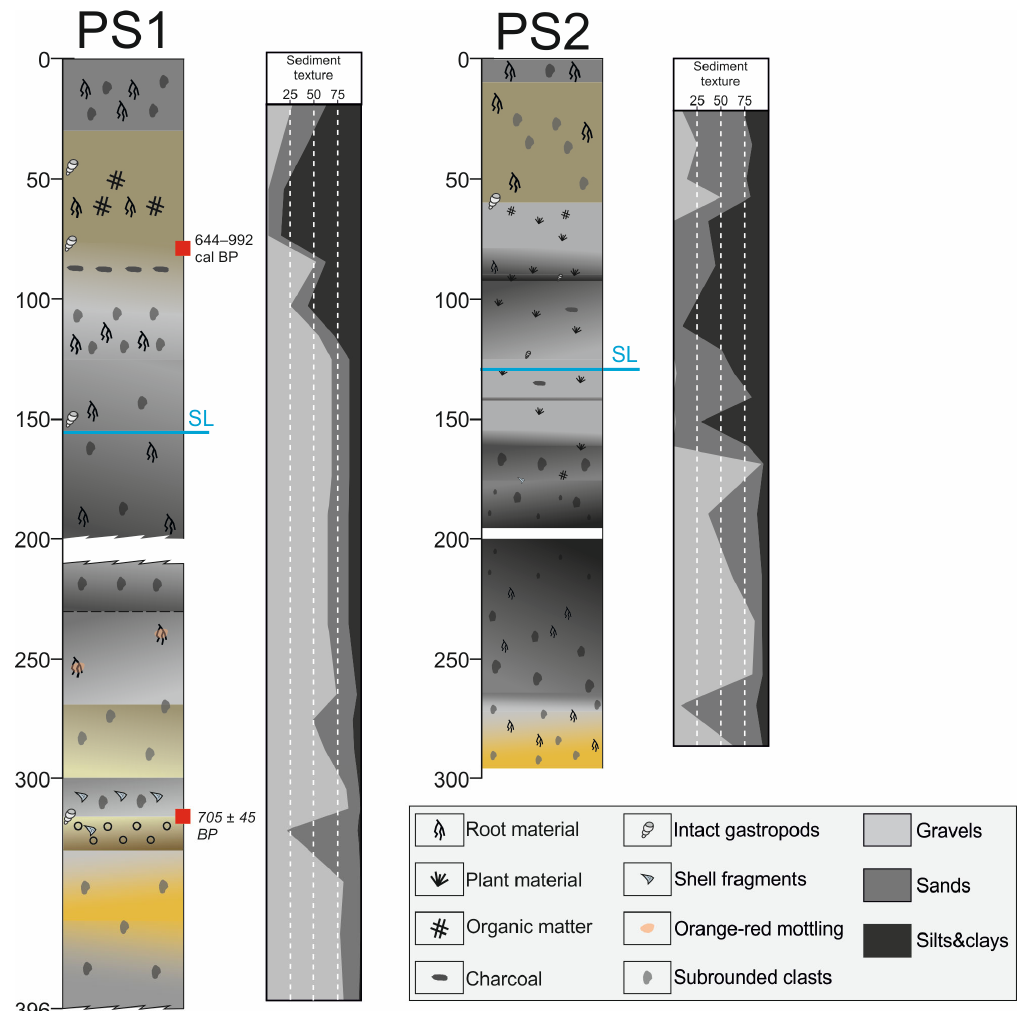
Figure 2. Stratigraphy and radiocarbon dating of PS1 and PS2 cores. Table 1. Radiocarbon ages for dated samples from Psatha cores.